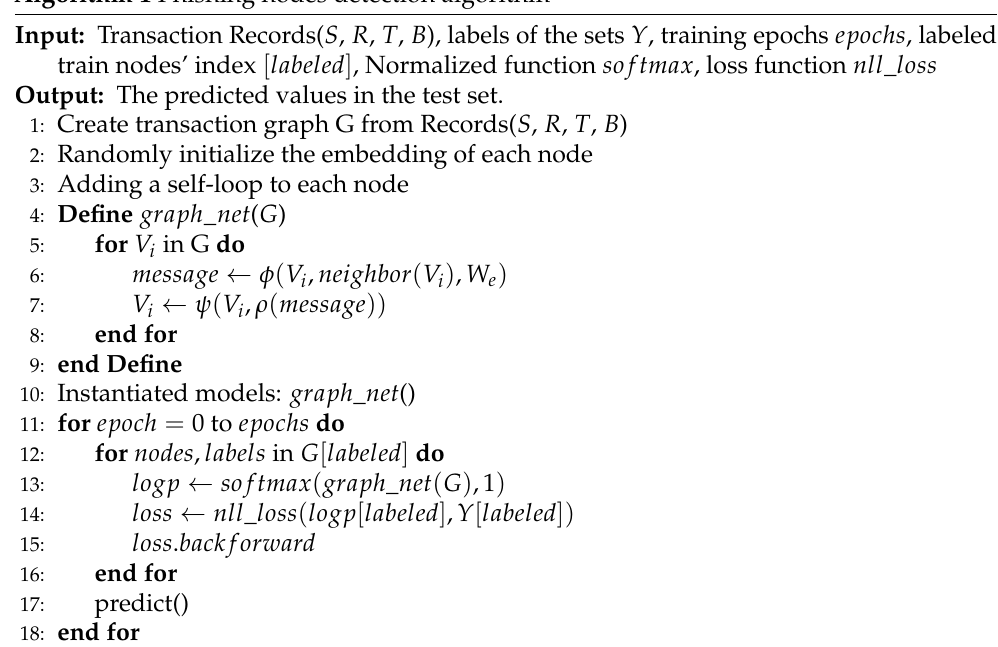
Algorithm 1 Phishing nodes detection